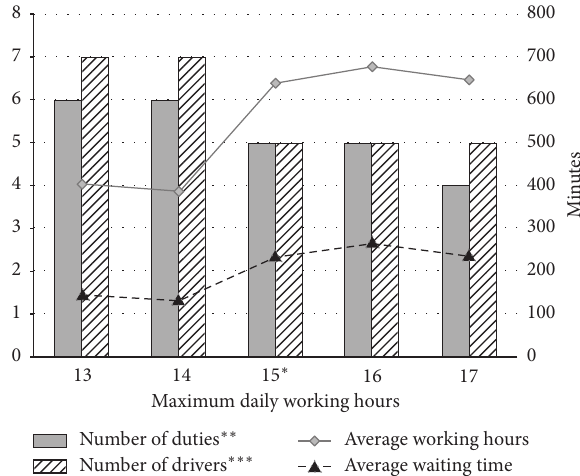
Figure 10: Sensitivity analysis of the maximum daily working hours. Note . ∗ Current value and comparison basis. ∗∗ The number of duties required to cover the timetable. ∗∗∗ The number of drivers required for the roster.